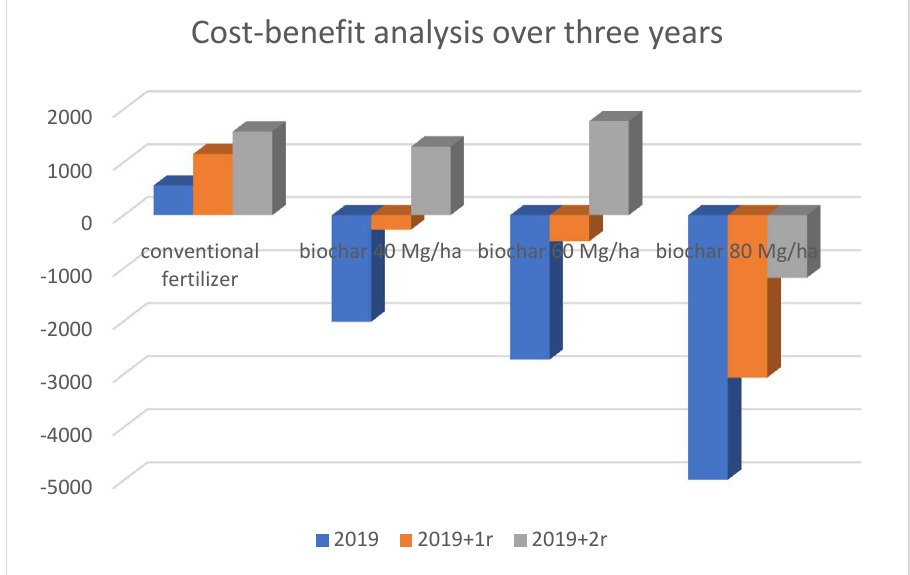
Figure 7. Comparison of the costs (in USD) of soil fertilization with conventional fertilizer and with the addition of biochar over a three-year period.